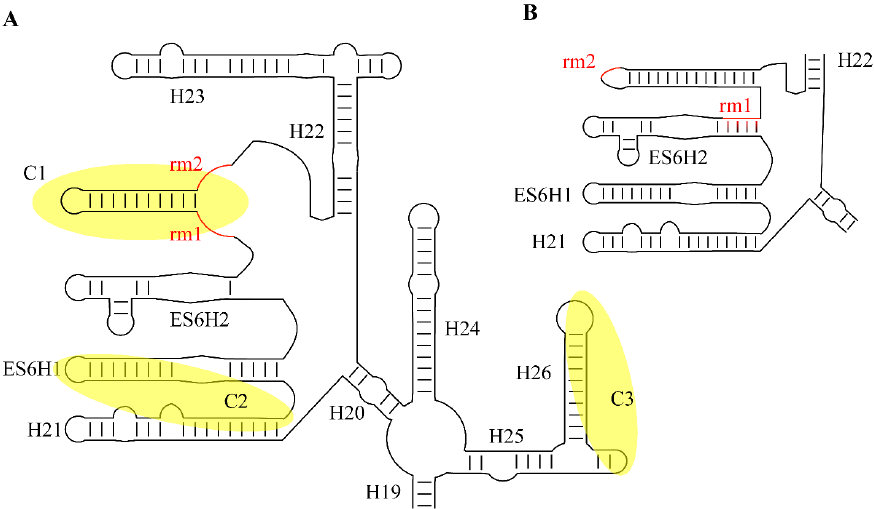
Figure 3. Conformational changes within ES6 of the 18S rRNA upon interaction with snR30. ( A ) Predicted rRNA conformation while snR30 base-pairs to the sequence elements rm1 and rm2 (red, crosslinking site C1) of the SSU processome. In addition, the crosslinking sites C2 and C3 are highlighted in yellow that were observed for S. cerevisiae snR30 (compare to Figure 2 for the corresponding crosslinking sites in snR30). ( B ) rRNA secondary structure of ES6 as visualized in cryo-EM models of the mature ribosome showing the different base-pairing in absence of snR30 [86].